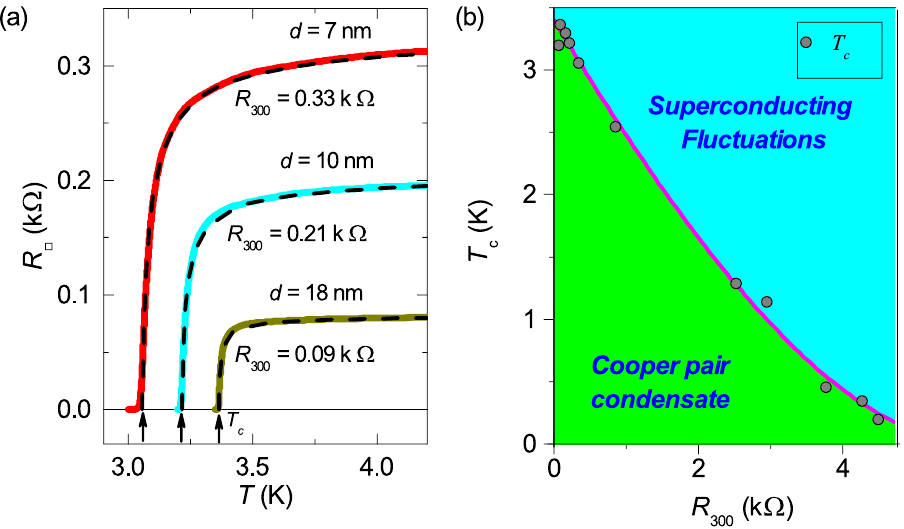
Figure 3. Superconducting critical temperature. ( a ) Determination of T c from quantum contributions to the conductivity. Solid lines: experimental resistances per square vs. temperature for three TiN film with different thicknesses d and different resistances at room temperature R 300 . Dashed lines are the same as in Fig. 2d, the fits account for all quantum contributions to conductivity. Arrows mark the respective superconducting critical temperatures T c . ( b ) The superconducting critical temperature T c vs . R 300 for the TiN films shown in Fig. 1a and published in refs 14, 46, 47. The solid line is the theoretical fitting by Eq. (9) with the adjustable parameter  γ τ = = . kT ln[ /( )] 5 73 , where T c 0 = 3.4 K and τ = 7.3 · 10 − 15 c 0